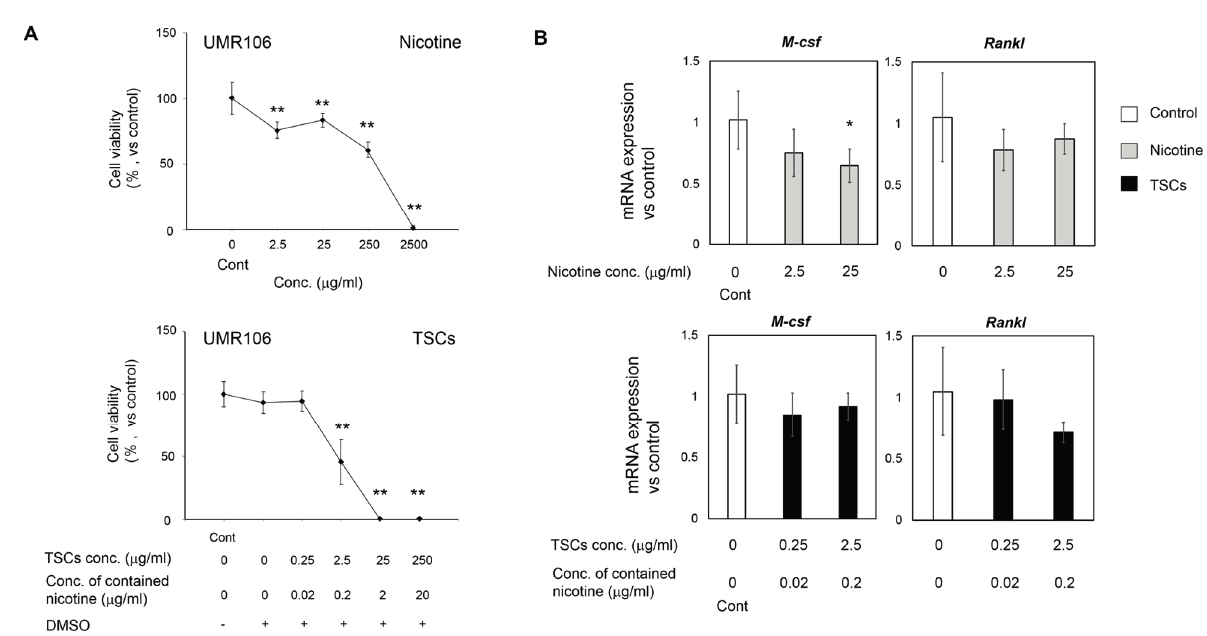
Figure 5. The effects of nicotine and TSC administration against osteoclastogenesis in vitro . TSCs: tobacco smoke components. ( A ) Cytotoxicity of nicotine and TSCs to UMR106. Cells were seeded at 6.3 × 10 3 /cm 2 and subjected to nicotine and TSCs at different concentrations for 9 and 6 days, respectively. All cell numbers were normalized against those treated with control medium; ( B ) M-csf and Rankl mRNA expression in UMR106. Cells were seeded at 2.8 × 10 4 /cm 2 and subjected to nicotine and TSCs at different concentrations for 48 h; ( C ) Cytotoxicity of nicotine and TSCs to the primary preosteoclasts. Cells were seeded at 1.9 × 10 5 /cm 2 and subjected to the adjunct culture medium containing RANKL (15 ng/mL) with/without TSCs and nicotine for 10 days. All cell numbers were normalized against those treated with adjunct culture medium; ( D ) TRAP staining and its quantitative data. Cells were treated as in ( C ). Scale Bar: 100 µm. The total number contains mononuclear and multinuclear TRAP-positive cells. All data show mean ± s.d. ( n = 3). ( A – C ) ** p < 0.01, * p < 0.05 compared with control (ANOVA with Dunnett’s test) and ( D ) ** p < 0.01 (ANOVA with a Tukey–Kramer